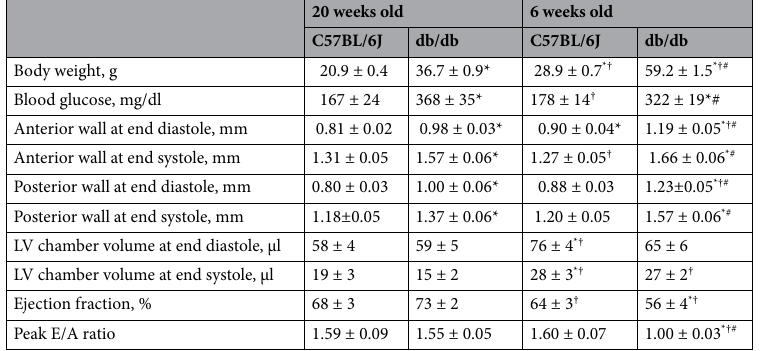
Table 1. Pathophysiological and echocardiographic parameters of C57BL/6J and db/db mice. LV left ventricular. *P < 0.05 versus 6-week-old C57BL/6J mice. † P < 0.05 versus 6-week- old db/db mice. # P < 0.05 versus 20-week-old C57BL/6J mice (n = 12–13